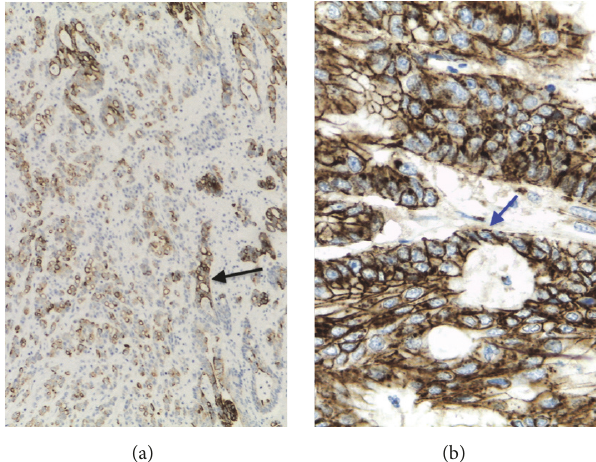
Figure 4: (a) Histologic image of the resected tumor (cytokeratin 34-beta-E12, 100x). Most of the neoplastic cells expressed high molecular- weight cytokeratins (black arrow). (b) Neoplastic cells showing diffuse membranous and cytoplasmic expression of beta-catenin (blue arrow). Note that there is no nuclei staining (beta-catenin,